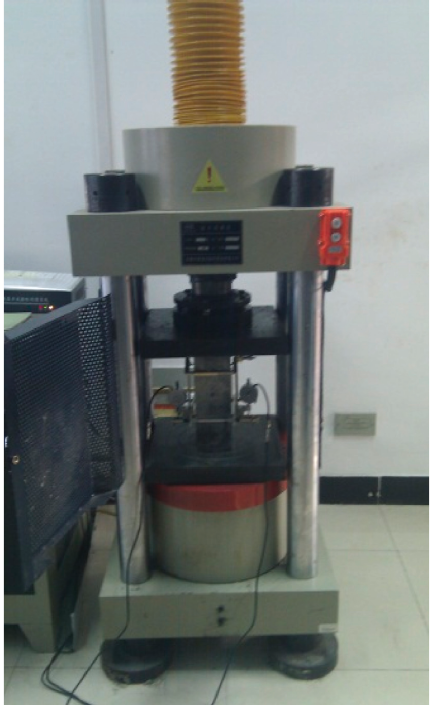
Figure 10: Elastic modulus of concrete.